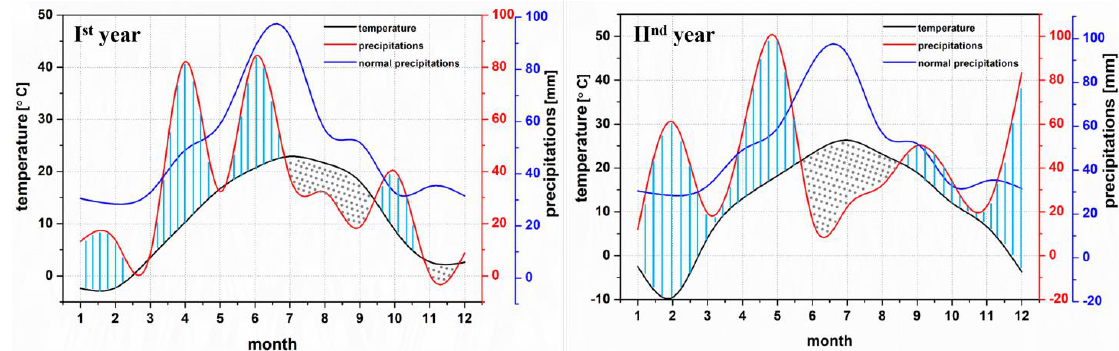
Figure 1. The ombrothermic charts for the studied years.